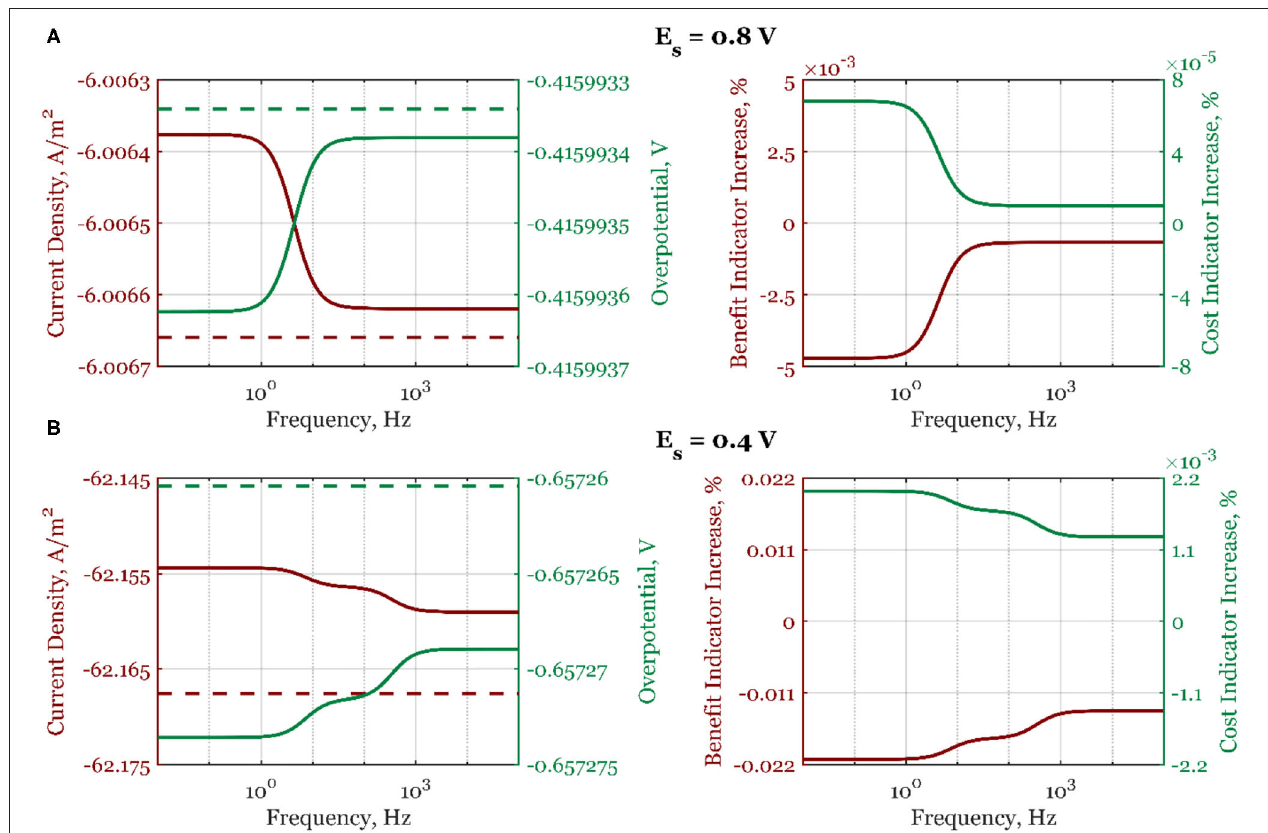
FIGURE 5 | The mean current density and overpotential values (left side) for steady-state (dashed line) and dynamic regime (full line), and the corresponding dynamic regime benefit and cost indicator increases relative to the steady-state regime (right side) when electrode rotation rate is periodically changed with the amplitude of 5% around the value ω r , s = 2,500 rpm, and for steady-state electrode potentials: (A) E s = 0.8V and (B) E s = 0.4V, in the frequency range of 10 − 2 -10 5 Hz.